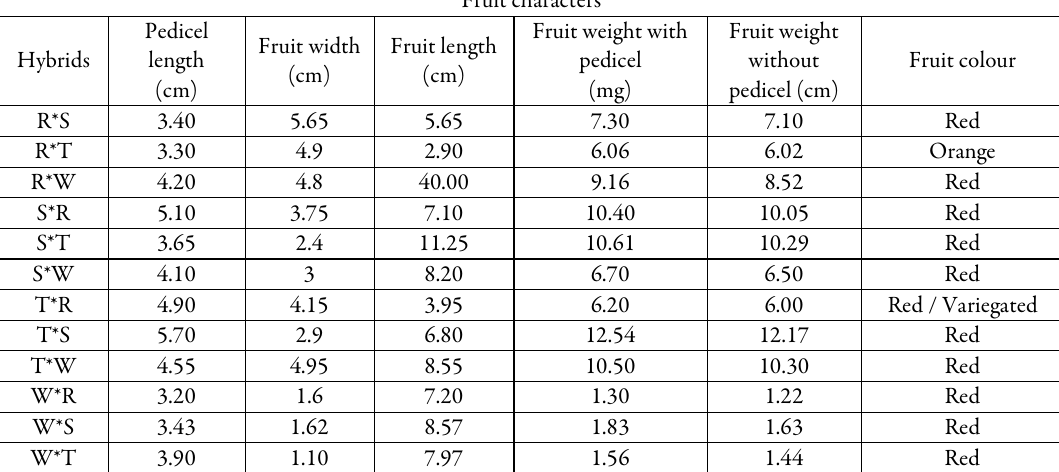
Fruit characters